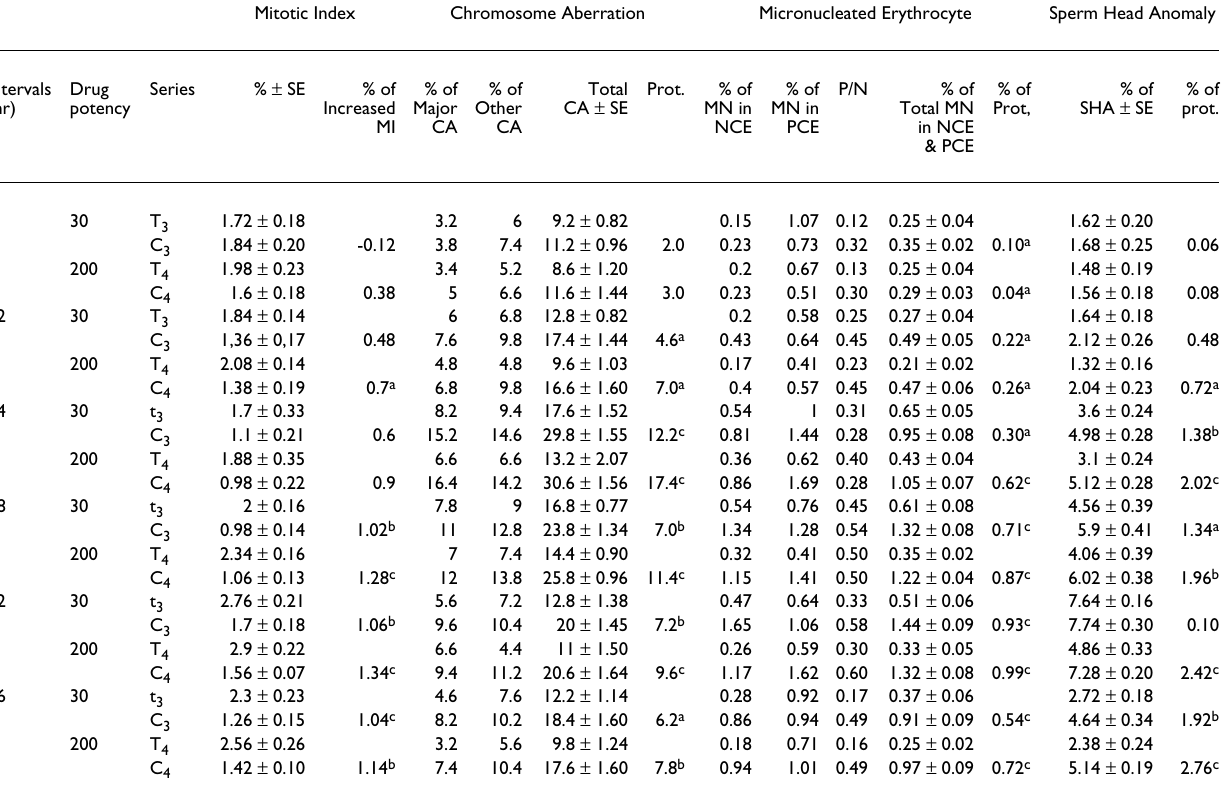
Table 2: Frequency distribution of Chromosome Aberrations (CA) in 500 bone marrow cells examined (100 cells from each